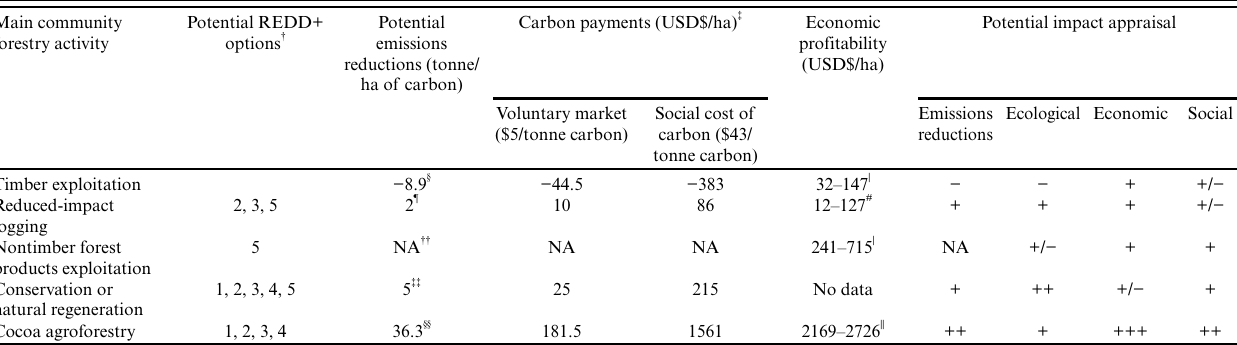
Table 2. Potential of key community forestry activities to achieve REDD+ targets and their impact appraisal in terms of emissions reductions and ecological, economic, and social